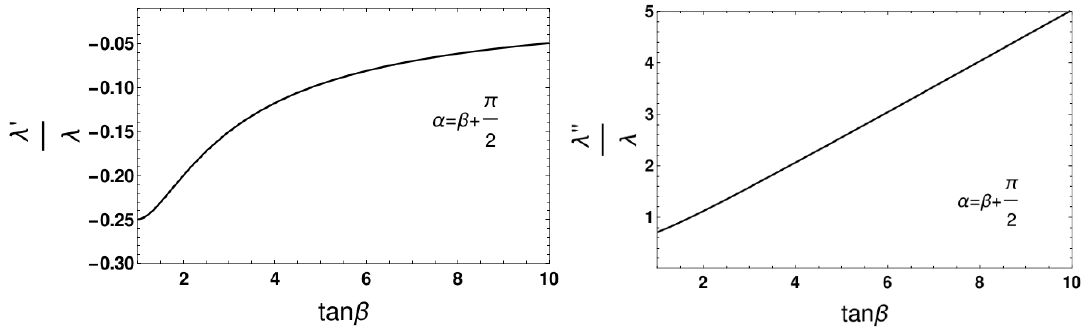
Figure 2 . Variation of (cid:21) 0 and (cid:21) 00 ( scaled by (cid:21) ) with tan (cid:12) . We assume (cid:11) = (cid:12) + (cid:25)= 2 for both the